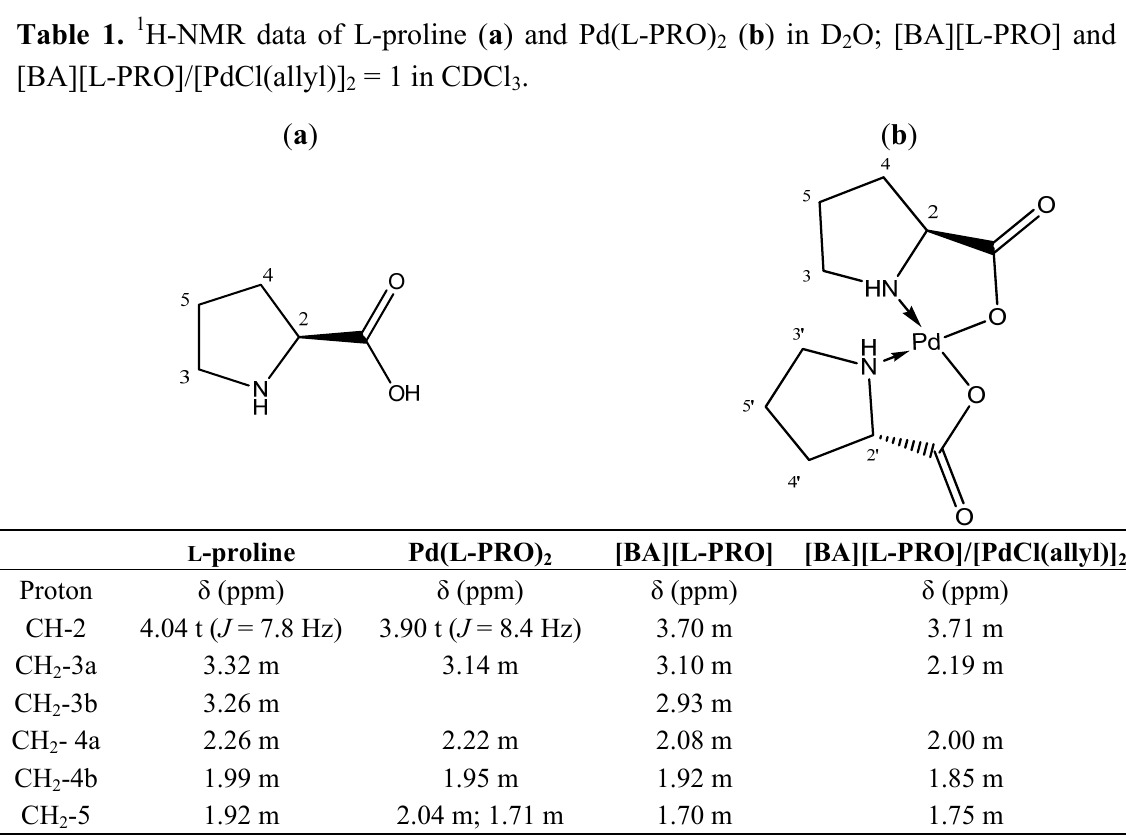
Table 1. 1 H-NMR data of L-proline ( a ) and Pd(L-PRO)